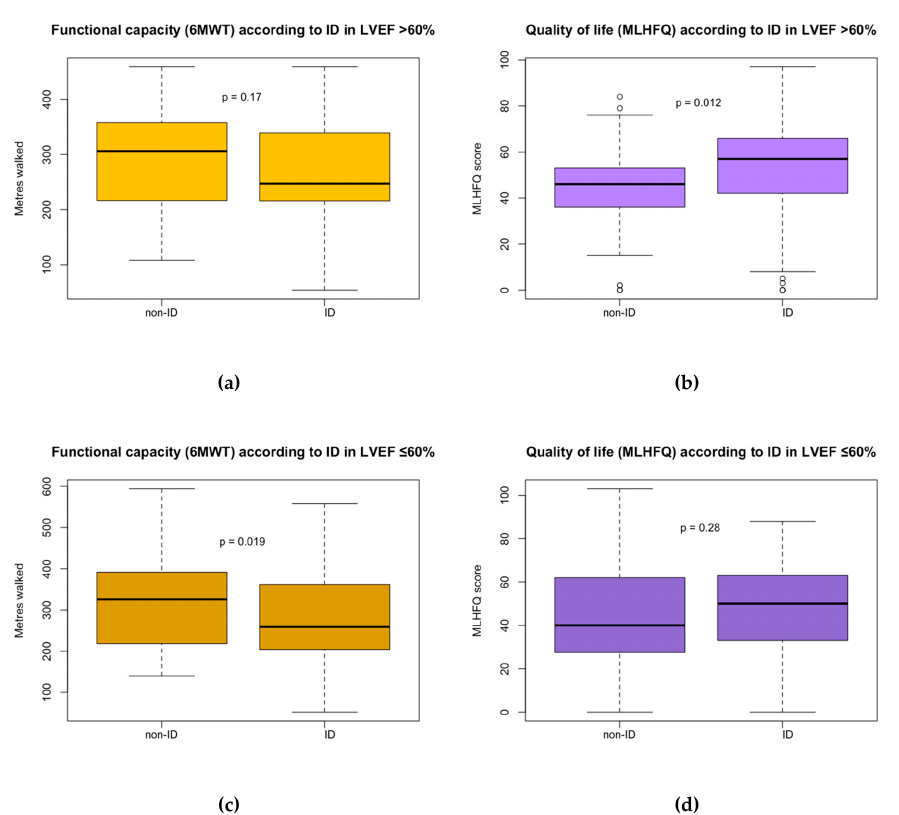
Figure 2. (a) Functional capacity (measured with 6MWT) according to iron deficiency in HFpEF with LVEF >60%. (b) Quality of life (measured with MLHFQ) according to iron deficiency in HFpEF with LVEF >60%. (c) Functional capacity (measured with 6MWT) according to iron deficiency in HFpEF with LVEF ≤ 60%. (d) Quality of life (measured with MLHFQ) according to iron deficiency in HFpEF with LVEF ≤ 60%.